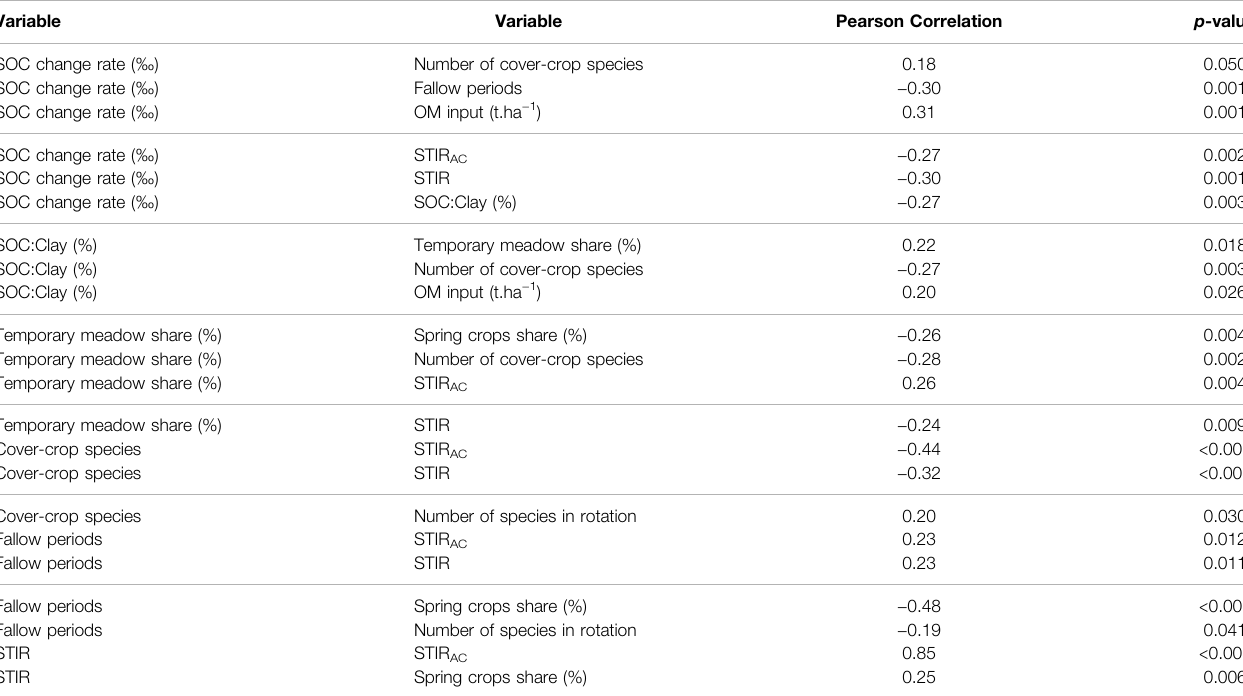
TABLE 4 | Pearson correlation coef fi cients and p -value of the signi fi cant correlations between rates of SOC annual change, cropping practices, and soil properties. SOC refers to the soil organic carbon content at the beginning of the 10-year period.